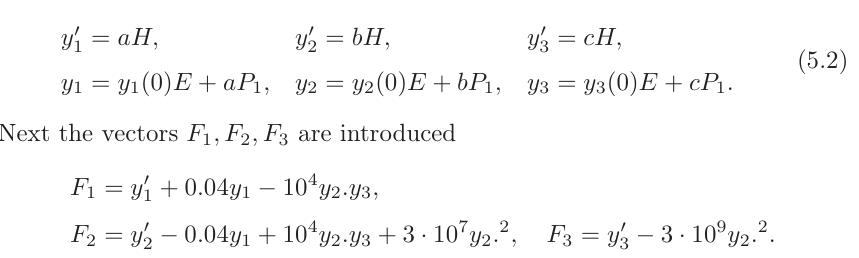
Qualitative analysis of (5.1) indicates that the component y 2 rapidly reaches its maximal value for which y ′ = 0 and 3 · 10 7 y 2 ≈ 0 . 04 , consequently max( y 2 ) ≈ 2 2 3 . 65 e − 5 ; after that the function y 2 decreases very slowly. Due to this